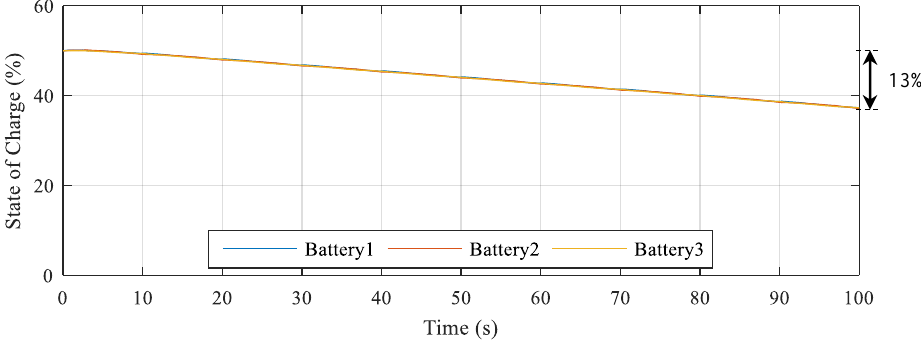
Figure 14. State of charge of batteries in the WECS with proposed controller (Case 2).